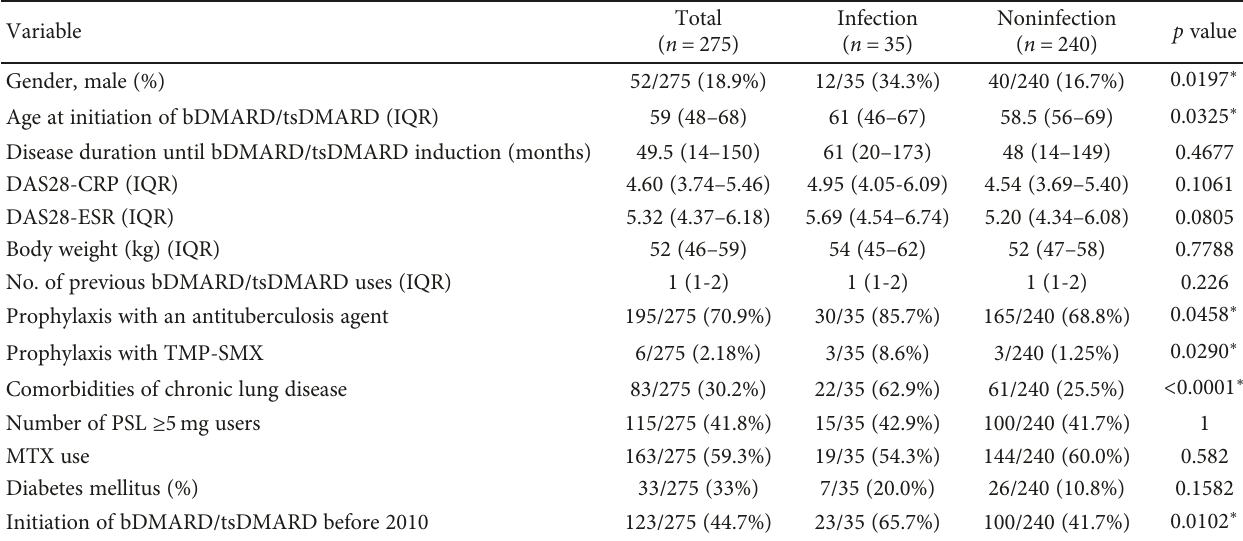
Table 1: Characteristics of the total, infection, and noninfection patient groups.